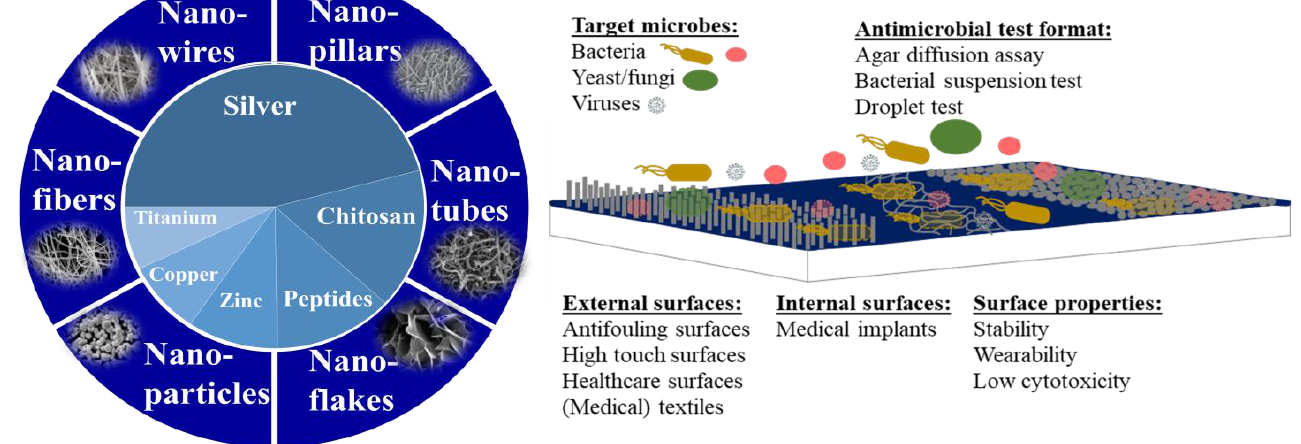
Figure 1. Forms of antimicrobial nanomaterials and the key properties of nanomaterial-based antimicrobial surfaces. Left side: antimicrobial agents based on literature search in ISI WoS (January 2022) when out of 33,000 articles matching keywords “antimicrob* AND nano*”, 12,552 were on silver, 4400 on chitosan, 3519 on peptides, 2663 on zinc, 2272 on copper, and 1975 on titanium. The physical forms of antimicrobial nanomaterials include elongated nanostructures, such as nanofibres, -wires, -pillars, or nanotubes, nanoparticles or other structures. Right side: nanoparticle, nanopillar or nanofiber structures deposited or embedded onto antimicrobial surfaces. Common surface types, key physico-chemical properties, microbial targets, and antimicrobial testing formats are shown.